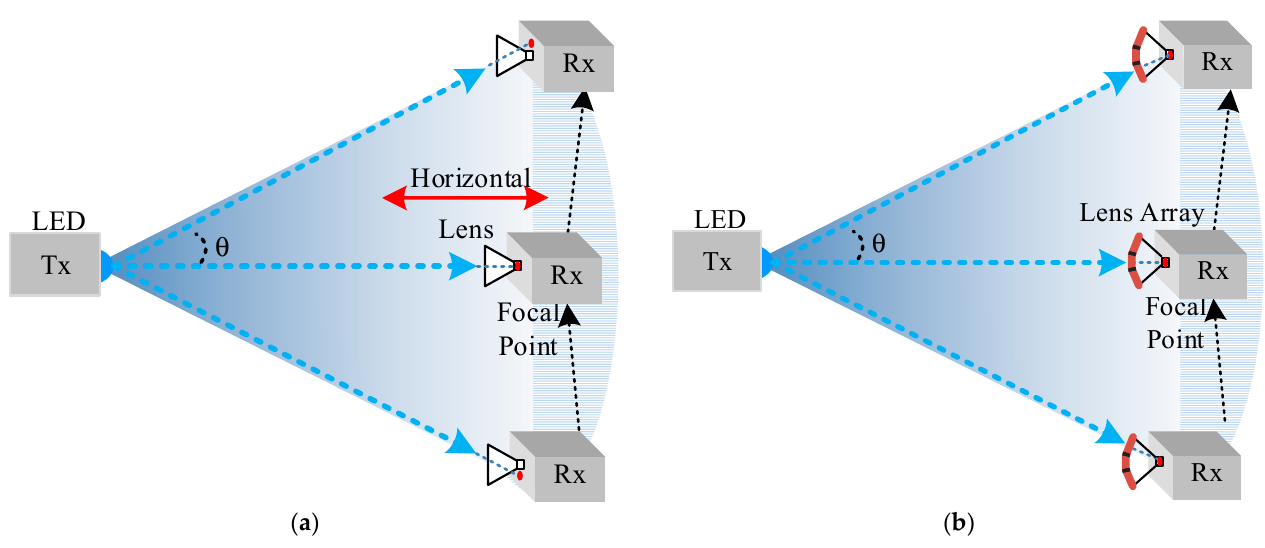
Figure 2. Schematic diagram of the dynamic UOWC system. ( a ) With one lens; ( b ) With lens array.